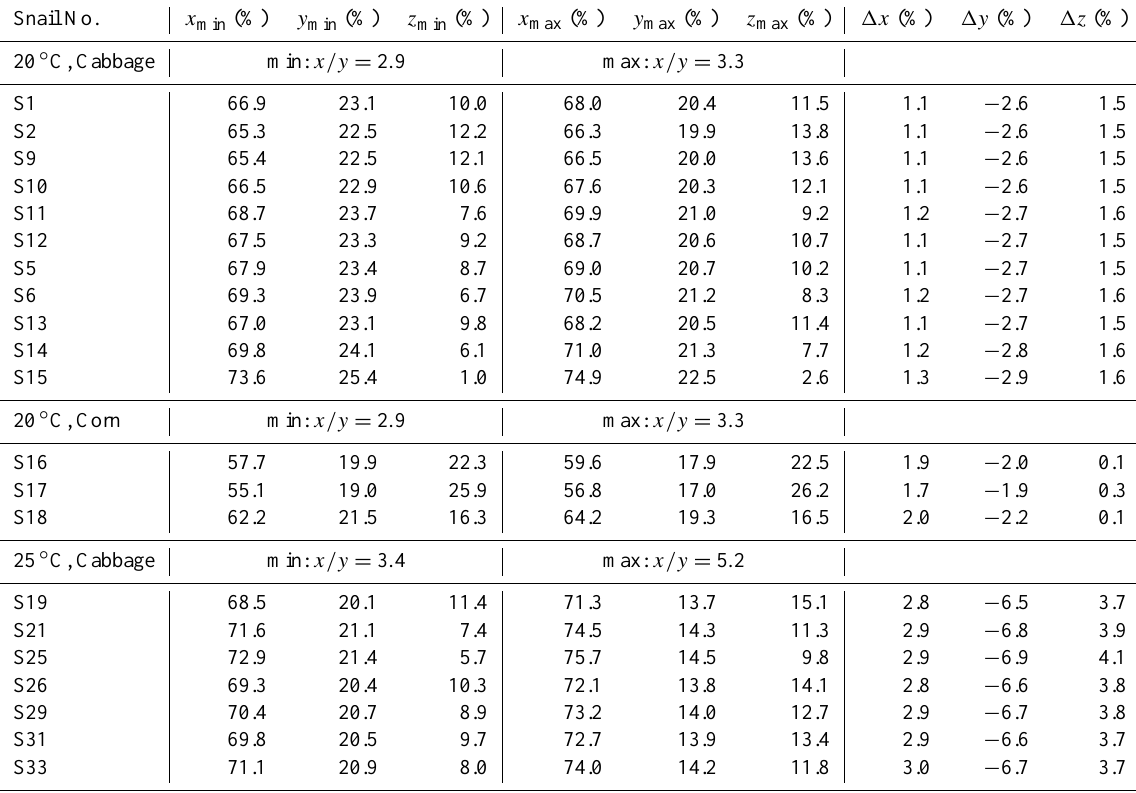
Table 2. Estimated x , y , and z under observed maximum and minimum x/y values at 20 ◦ C and 25 ◦ C. Snail